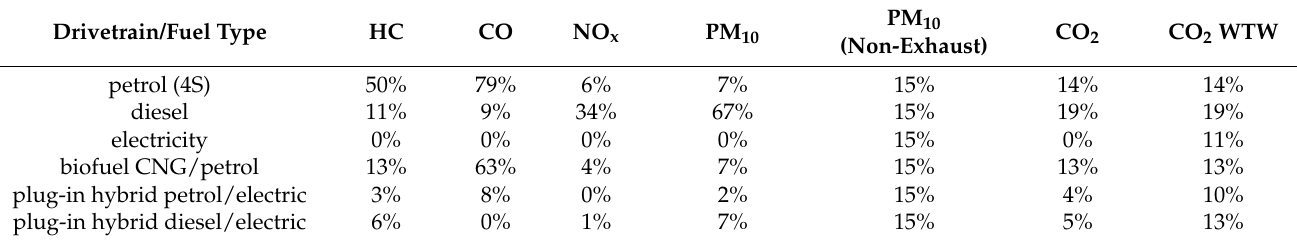
Table 3. Maximum mode share for varying delivery vehicle drive trains (average over all operating areas). Drivetrain/Fuel